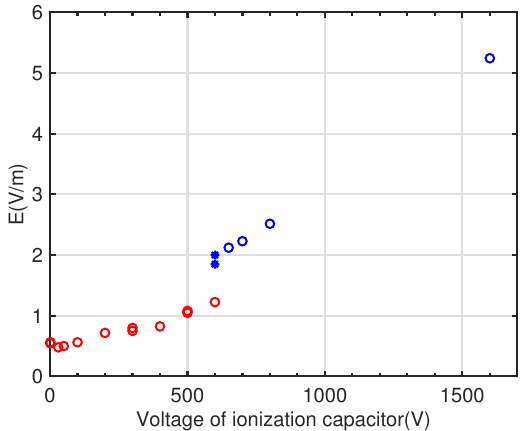
Figure 3. Operational space for pure Ohmic heating start-up and ECH assisted start-up on J-TEXT. A circle means the discharges were successful while an asterisk indicates the shot failed. The blue represents that it is a pure Ohmic heating start-up while the red represents EC assisted